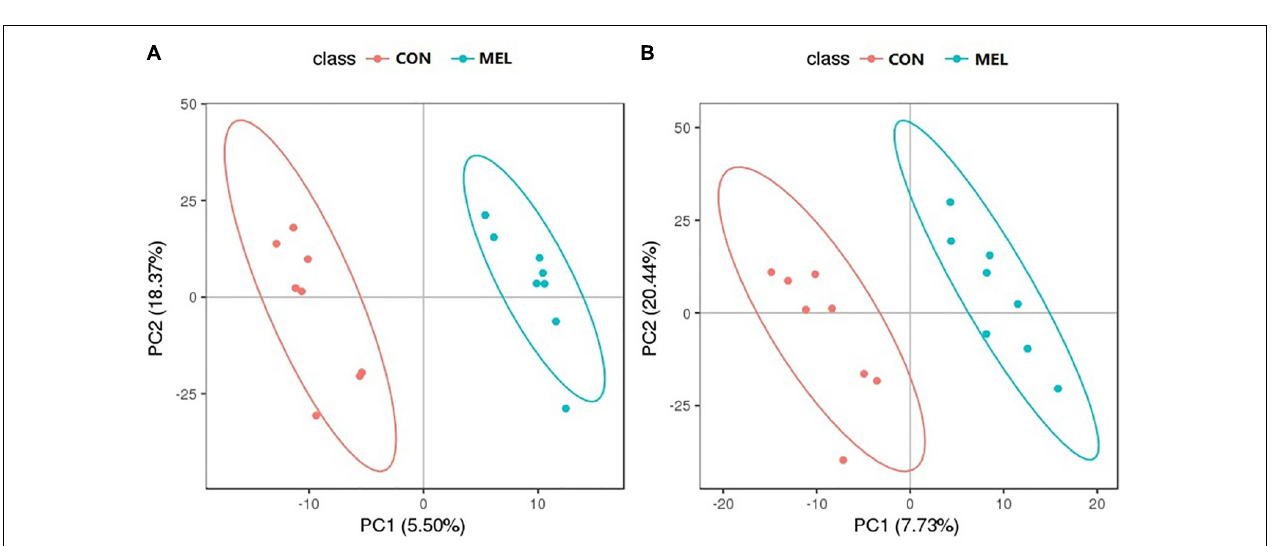
FIGURE 2 | Total number of steps taken (A) , stride length (C) , and stride frequency (D) of A. japonicus in the different treatment groups 9 h after intraperitoneal injection with melatonin or the control and the number of steps taken within each hour interval before and after injection with melatonin or the control (B) . Results are shown as the mean ± SEM. Different letters indicate significant differences ( N = 12, p < 0.05).